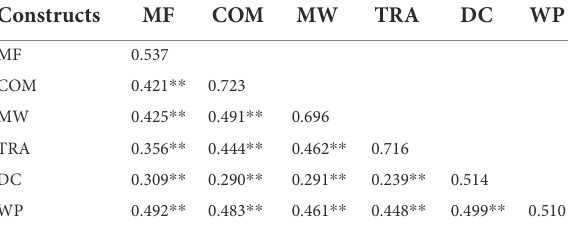
TABLE 4 Correlation coefficient matrix and square root of AVE value of each variable in the formal questionnaire. Constructs